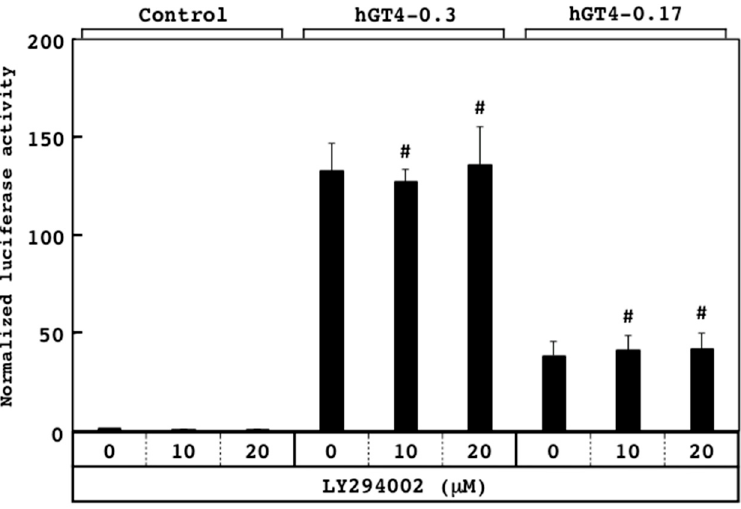
Figure 5. Effects of LY294002 on the promoter activities of the hGT4-0.3- and hGT4-0.17-sensor cells using 96-well tissue culture plates. The luciferase activity of the control cells was set at 1.0. Data show means ± S.D. #, no significant difference against control.